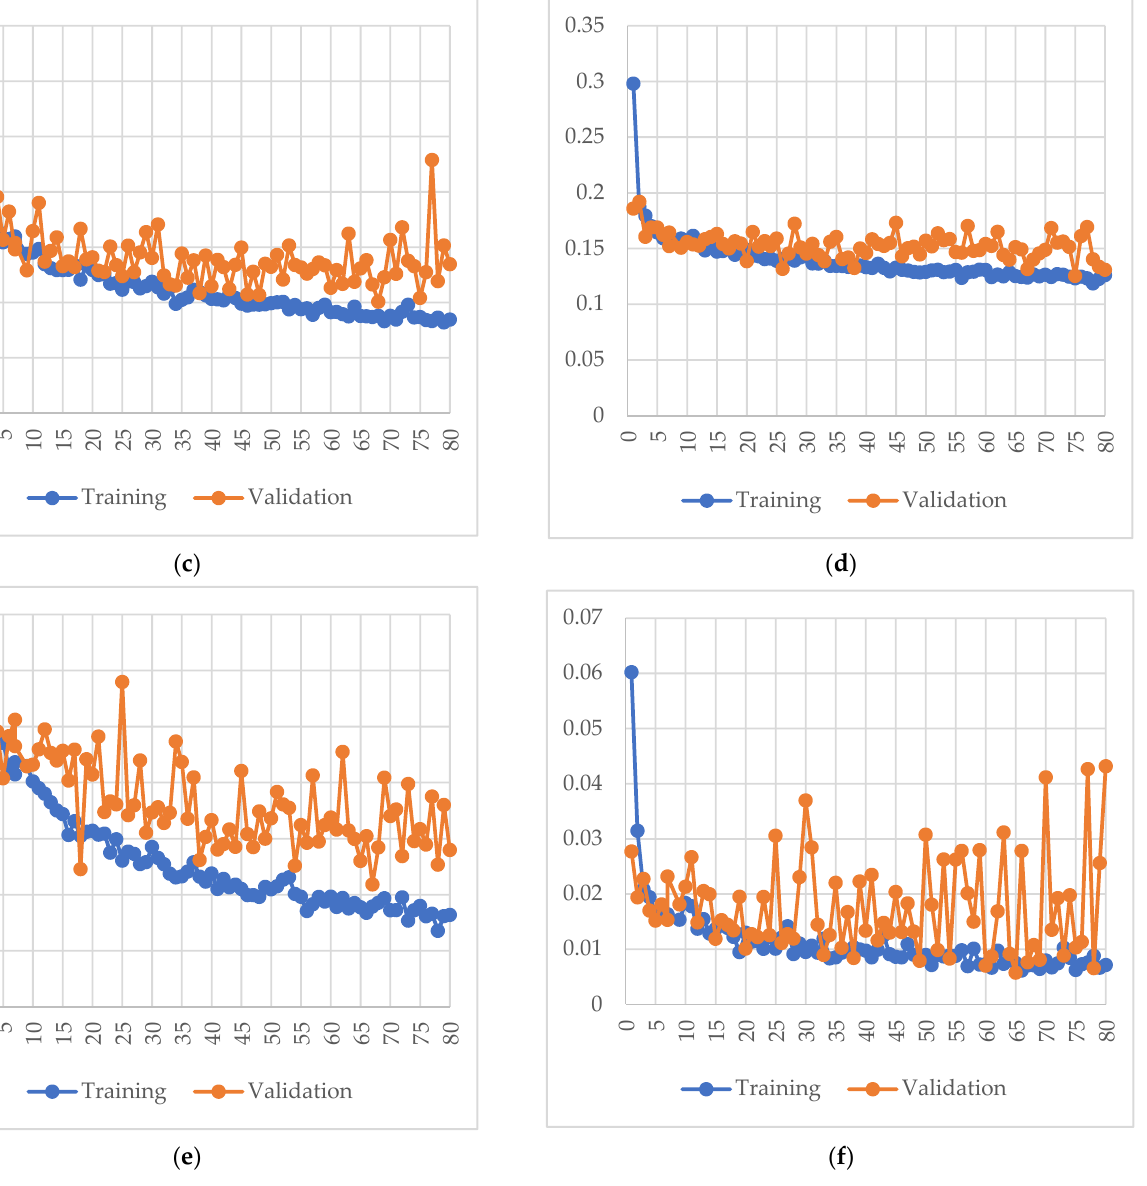
Figure 11. Mask R-CNN loss results from training losses and validation losses, ( a ) Total loss; ( b ) Mask R-CNN head bounding box loss; ( c ) Mask R-CNN head class loss; ( d ) Mask R-CNN mask loss; ( e ) RPN bounding box loss and ( f ) RPN class loss.